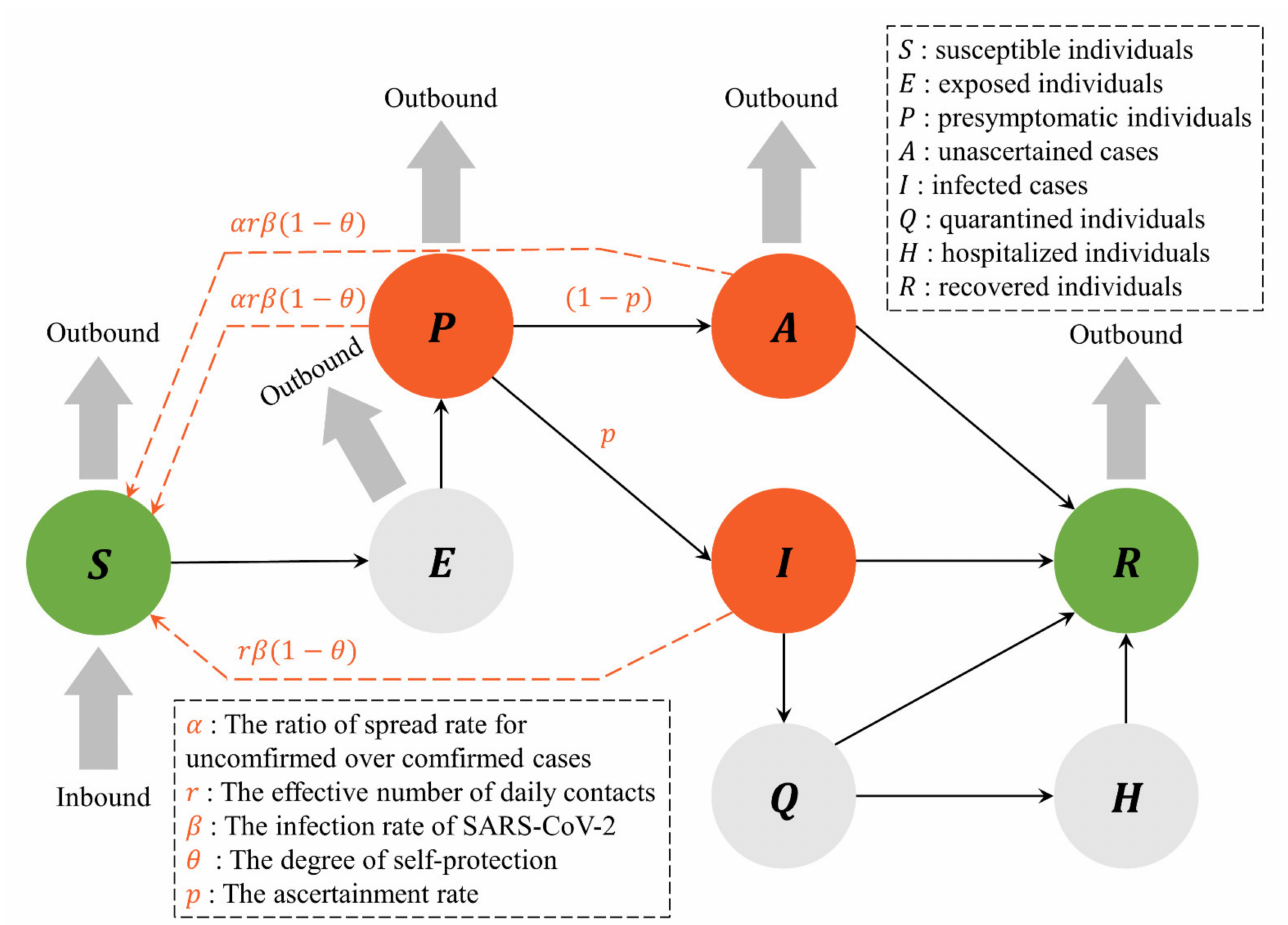
Figure 1. The framework of the infectious disease model. The black solid line indicates the transmission dynamics of the COVID-19 epidemic in each